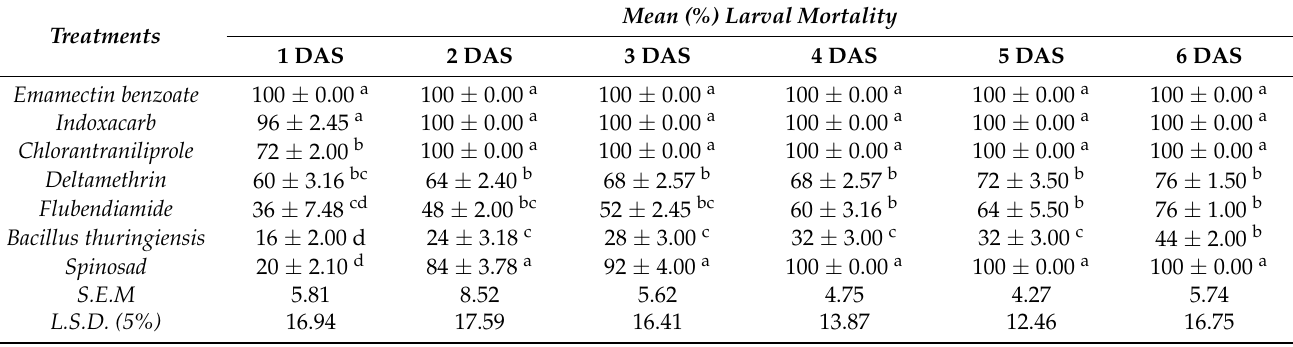
Table 3. Larval mortality over time after exposure to different insecticides against third instar larvae of H. armigera using the contact application.